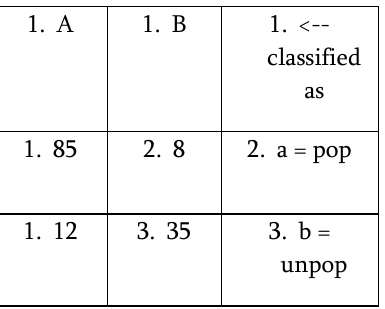
Table6.1 Confusion Matrix of J48: